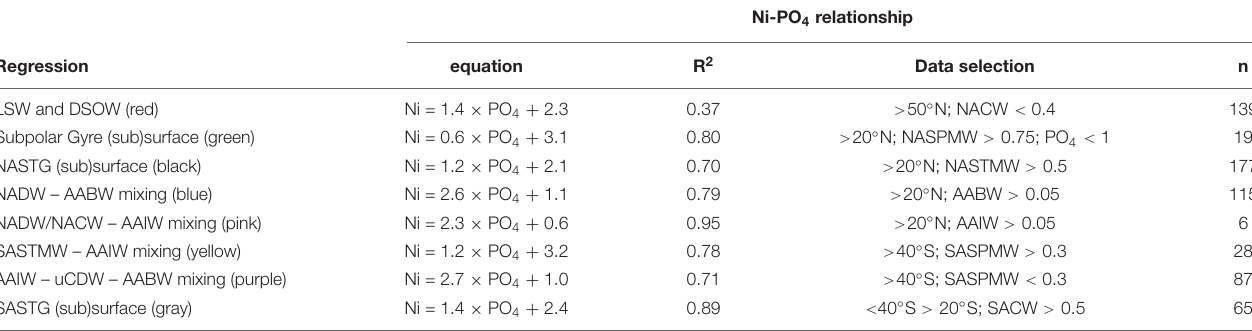
TABLE 3 | Regression lines as depicted in Figure 6